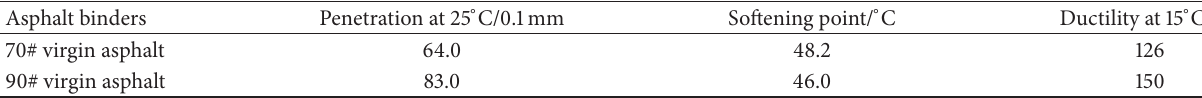
Table 1: General technical properties of virgin asphalt.